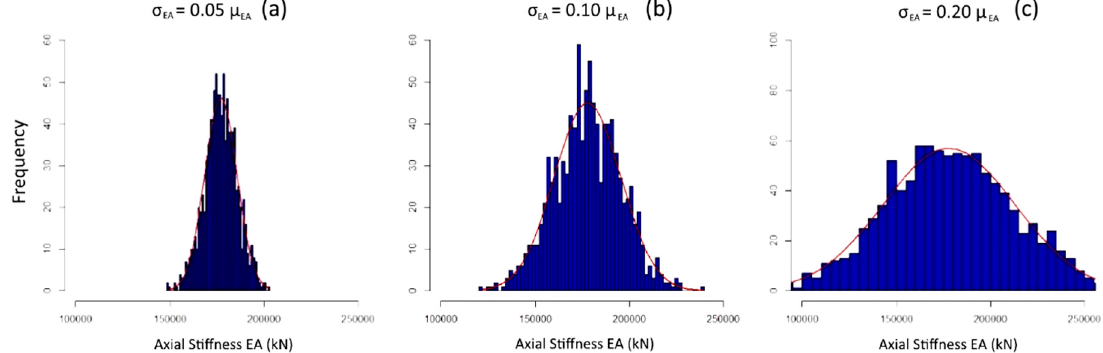
Figure 9. Probabilistic distributions of the strain stiffness EA with the variability 5% ( a ), 10% ( b ) and 20% ( c ). The red line represents the best-fit theoretical distribution function.